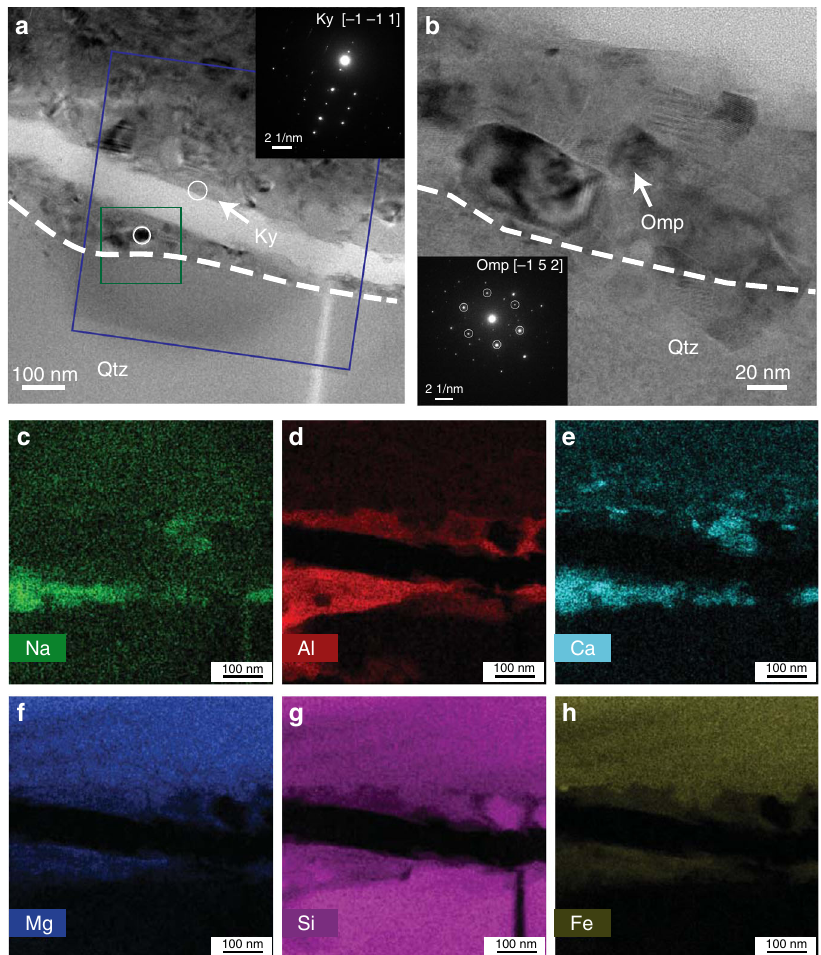
Fig. 7 TEM micrographs and element distribution maps along a fault zone in D1996. a An NSB (above the dashed line) consisting of nano-grained reaction products, majority of which are less than 50 nm. One Ky grain is identi fi ed at the edge of the crack in the fault zone by the inset SAED pattern. b Enlarged area of the green box in a , where an Omp grain about 30 nm is identi fi ed by SAED (inset). No amorphous materials are found. c – h Element distribution maps of the area indicated by the blue box in a . Omp appears below the crack at the Qtz grain boundary, showing characteristic enrichment in Na, Al, and Ca. Ky appears above the crack, enriched in Al but depleted in Na and Ca. This FIB foil was cut from the location indicated by the short red line